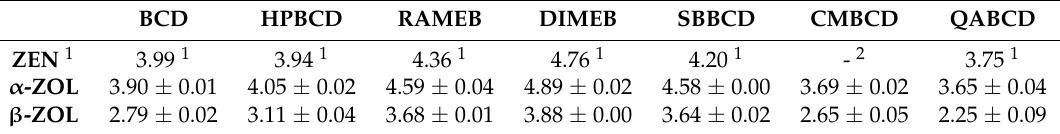
Table 2. Decimal logarithmic values of binding constants ( K ; dm 3 /mol) of ZOL-CD complexes determined by non-linear fitting with the Hyperquad program (Equations (2)–(7)) in 0.05 M